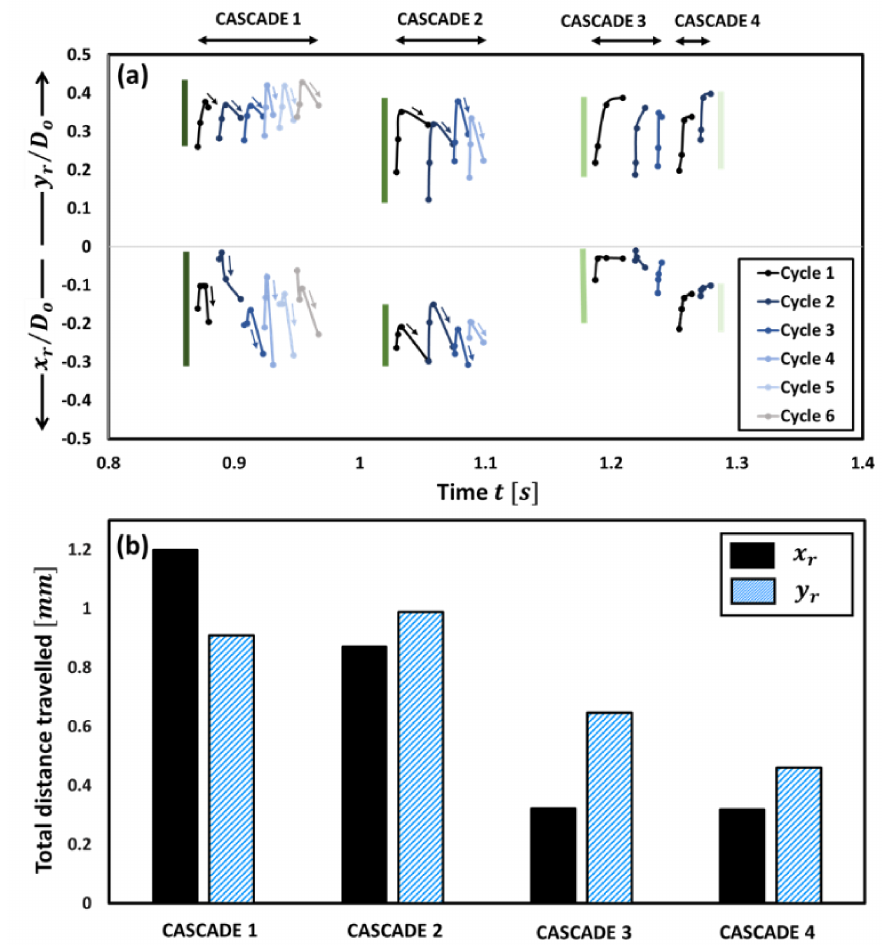
Figure 3. ( a ) Spatial movement of the centroid coordinates ( x r , y r ) of rupture sites with time for each cascade. The double-headed arrows on the top show the time duration of each cascade. The vertical bars indicate the extent of spatial shifting. ( b ) The total distance traversed by both the centroid coordinates during each